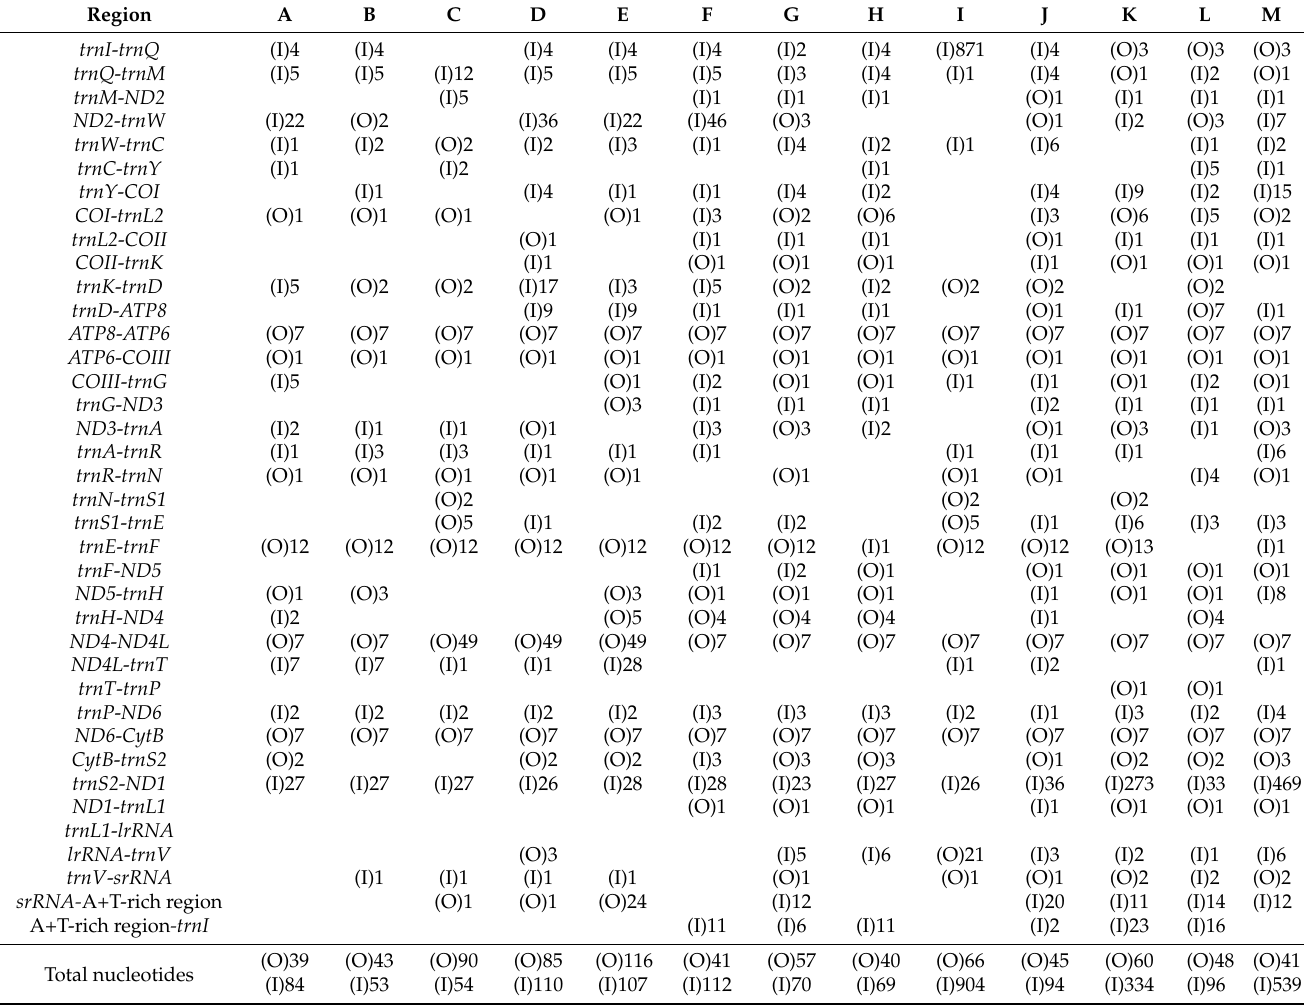
Table 4. Overlapping and intergenic spacer sequences in the mitochondrial genomes of Psyllidae species.